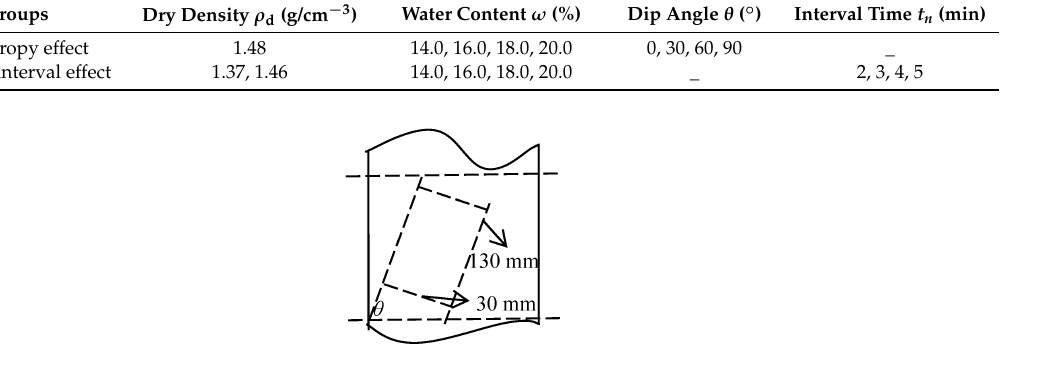
Figure 6. Cutting model of undisturbed loess.